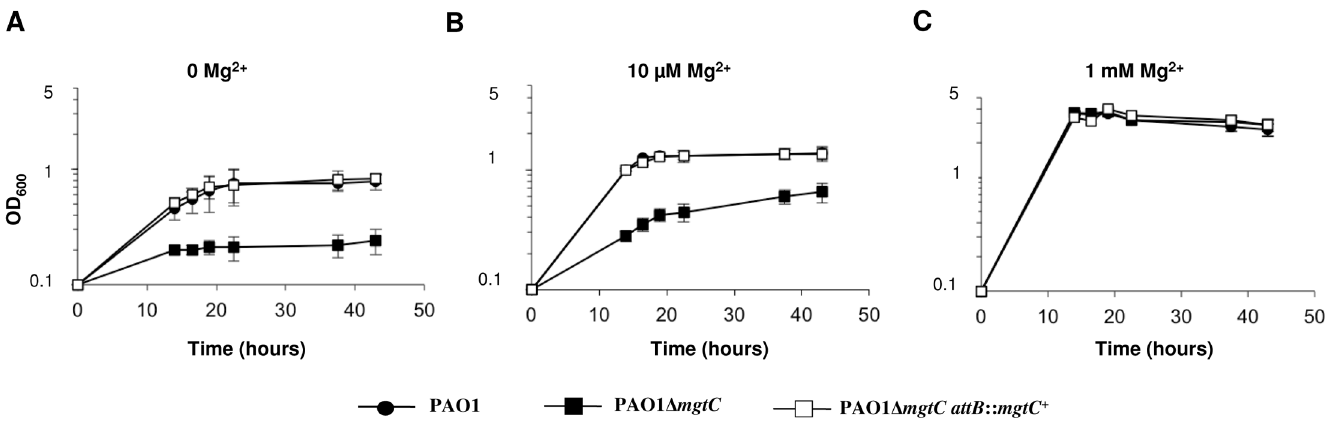
Fig 6. MgtC is required for growth of P . aeruginosa in Mg 2+ deprived medium. (A) P . aeruginosa strains PAO1, PAO1 Δ mgtC , and PAO1 Δ mgtC attB :: mgtC + were grown at 30°C in minimal medium without MgSO 4 . OD 600 is indicated over the growth period. The experiment was independently repeated three times and results are expressed as means ± SD. Statistical analyses indicate significant difference between growth of the mgtC mutant and the wild-type or the complemented strain (Student ’ s t test, P < 0.001 at times 20 hrs and 40 hrs). (B) The same strains were grown in medium with 10 μ M MgSO 4 . Statistical analyses indicate significant difference between growth of the mgtC mutant and the wild-type or the complemented strain (Student ’ s t test, P < 0.001 at times 20 hrs and 40 hrs). (C) The same strains were grown in high magnesium medium (1 mM MgSO 4 ). No significant difference is found between the three strains.